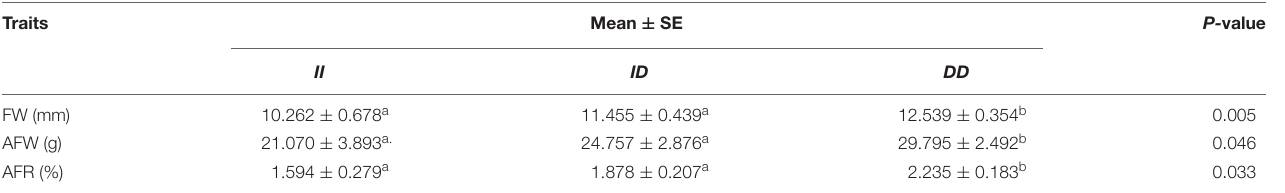
FW, fat width; AFW, abdominal fat weight; AFR, abdominal fat rate. Different lowercase letters indicate significant differences (P < 0.05), and the same letters indicate no difference (P > 0.05).